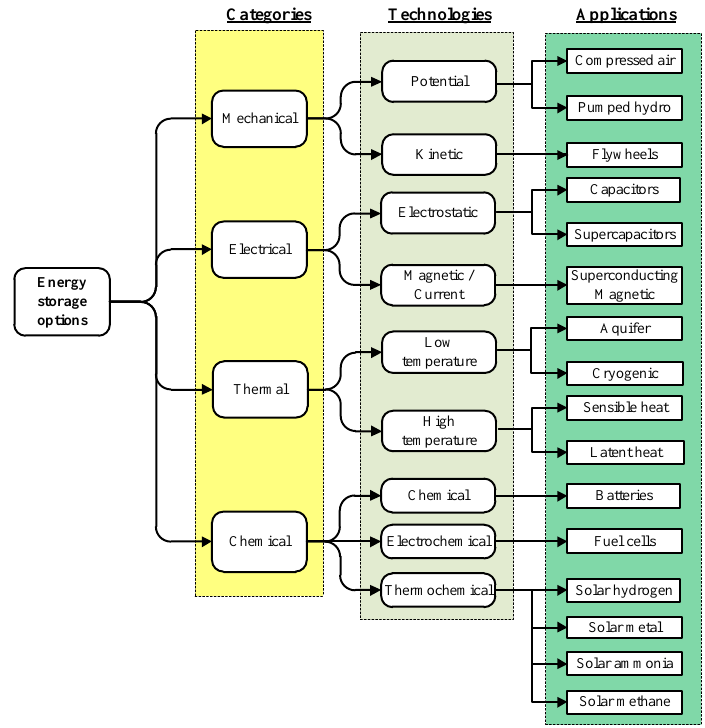
Figure 1. Categorization of energy storage options and applications.